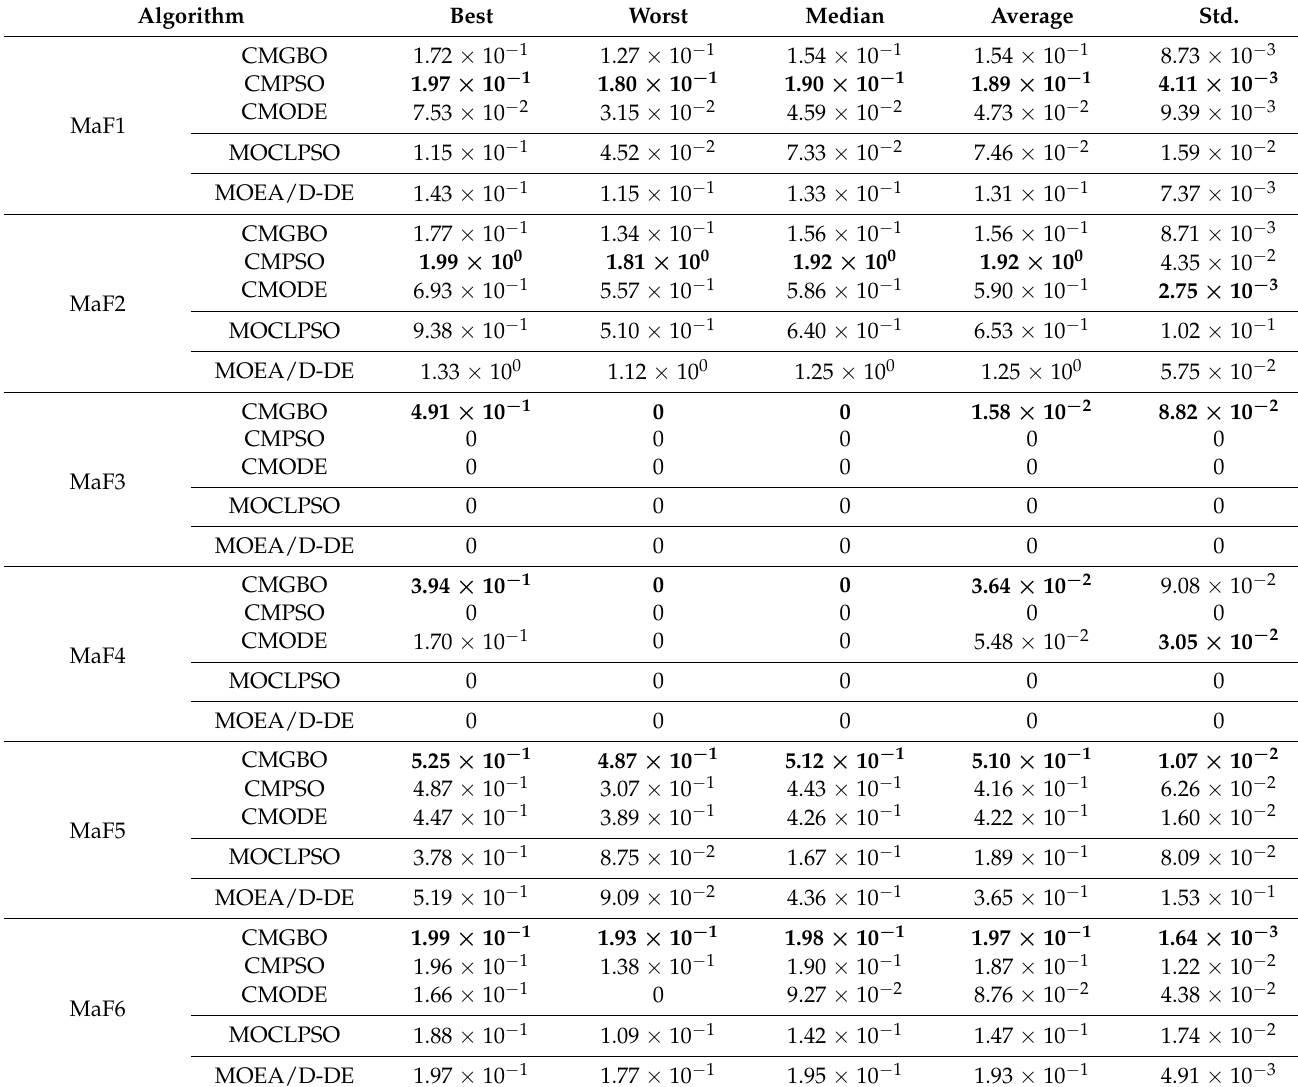
Table 6. Statistical results for HV on MaF test functions.